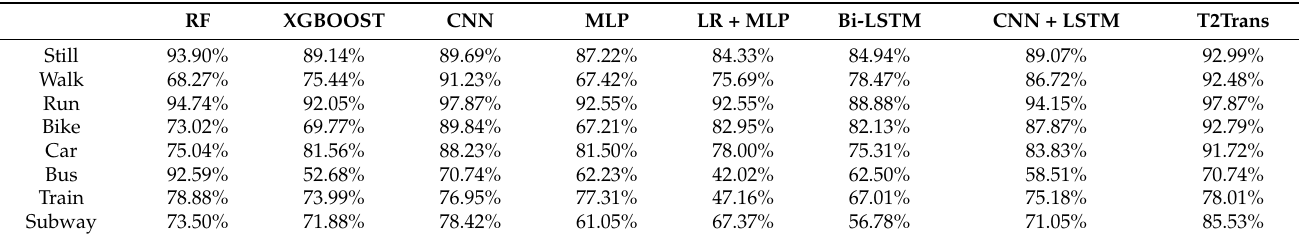
Table 7. Performance comparison between the algorithms of the best teams and the T2Trans algorithm on the HTC dataset for the third SHL recognition challenge.